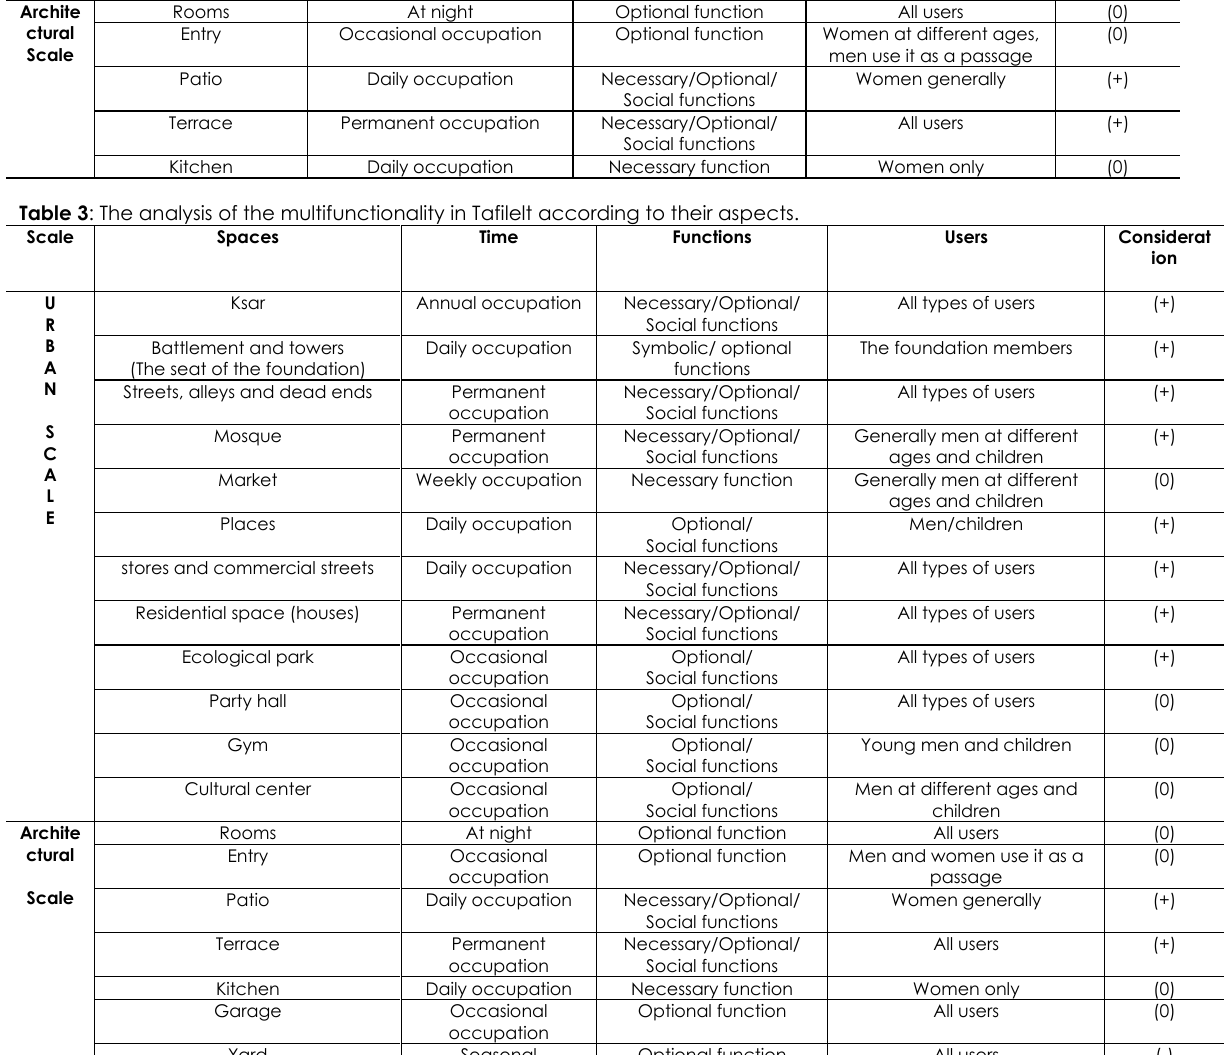
Table 3 : The analysis of the multifunctionality in Tafilelt according to their aspects. Scale